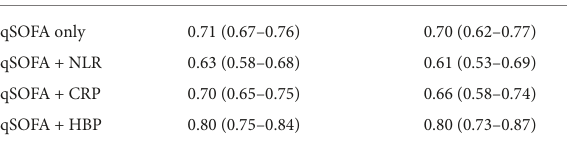
TABLE 3 Discrimination of qSOFA and modified qSOFA prediction models in derivation and validation